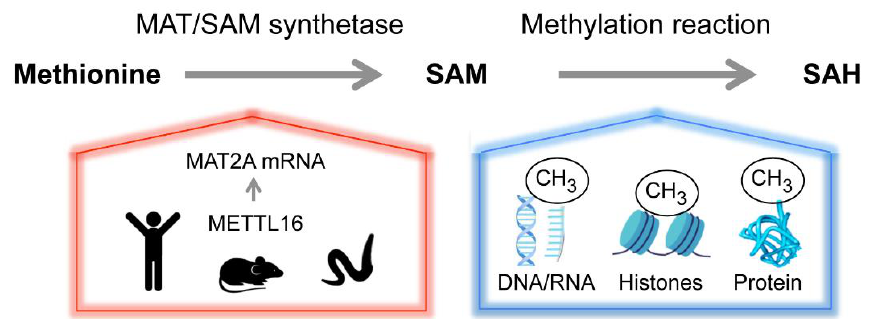
Figure 2. Homeostasis of the versatile methyl donor S-adenosyl-methionine (SAM or AdoMet). Methionine adenosyltransferase (MAT or SAM synthetase) catalyzes the formation of SAM from methionine and ATP. Methyltransferases transfer the methyl group from SAM to a variety of acceptor molecules (e.g., nucleic acids, proteins and lipids). The product, S-adenosylhomocysteine (SAH), is recycled to regenerate methionine but can also act as an allosteric regulator. SAM contributes to several biosynthetic pathways and is central to many cellular functions, including epigenetic regulation, cell growth and maintaining the redox status of the cell. The physiological levels of SAM are tightly controlled. In human, mouse and C. elegans , the m 6 A RNA methyltransferase METTL16 senses SAM and controls the abundance of SAM synthetase MAT2A mRNA